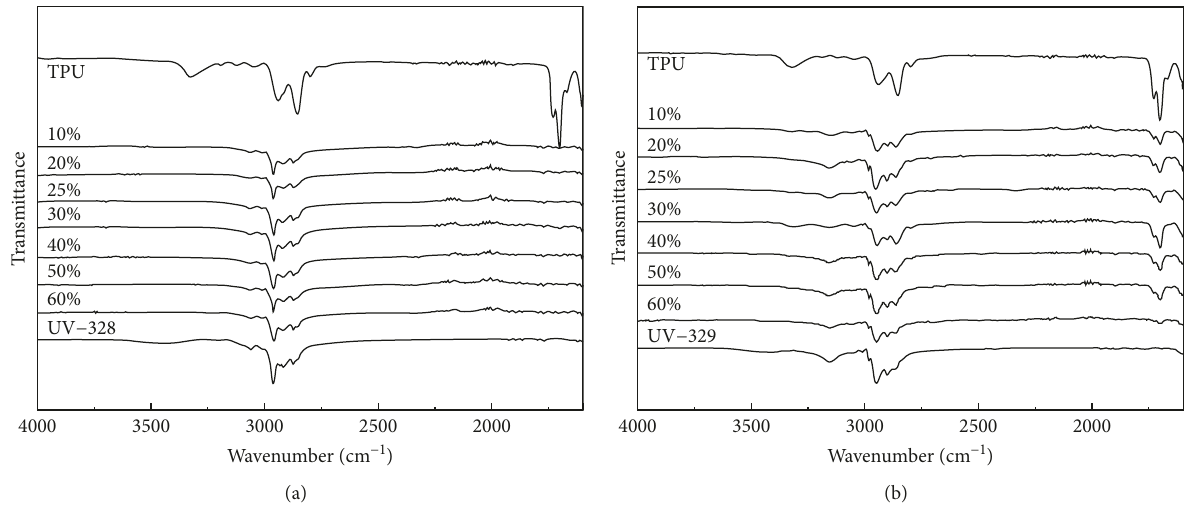
Figure 4: FTIR spectra of (a) 328-composites and (b) 329-composites with different mass ratios of